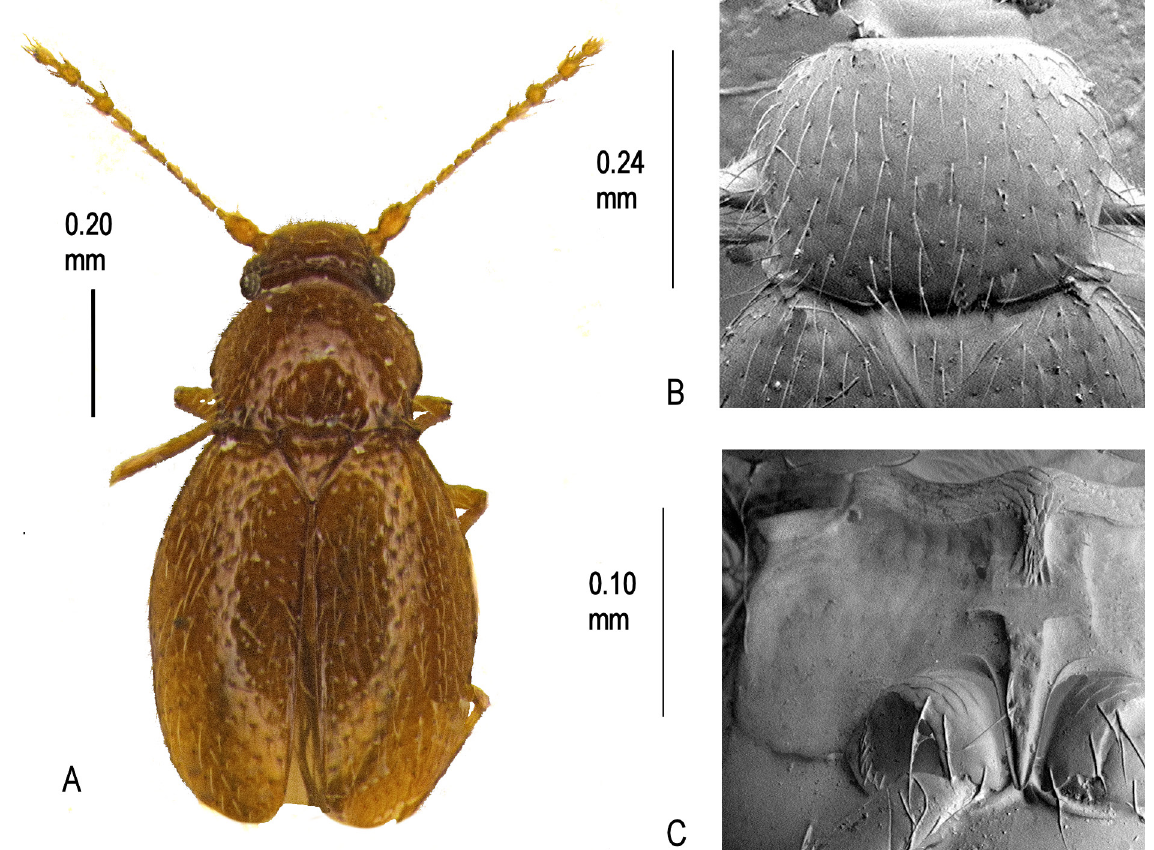
Fig. 83 . Cissidium sueae sp. nov. A . Habitus. B . Pronotum, × 345. C . Mesoventrite showing median process of collar, lateral margin, mid-keel and keel,